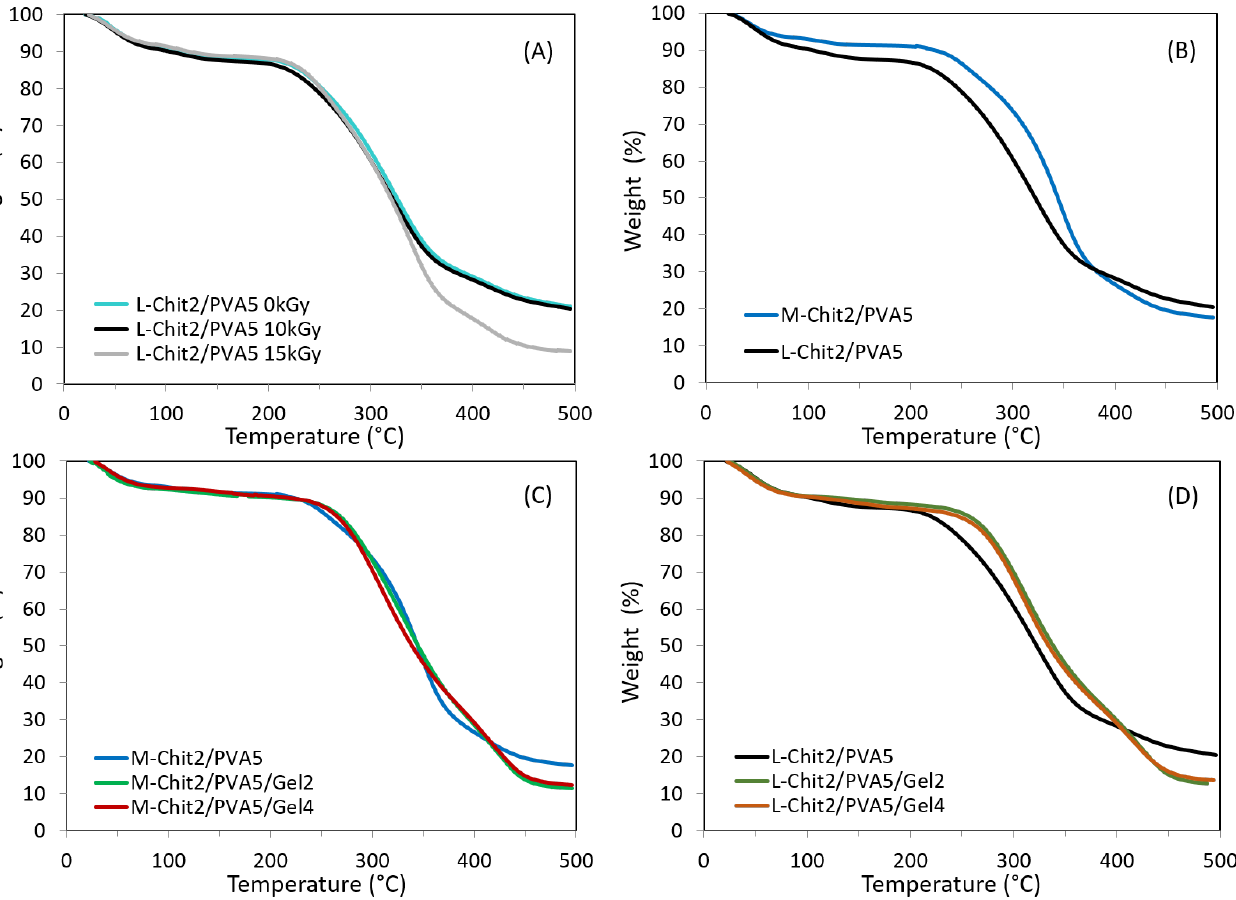
Figure 1. Membranes’ thermogravimetric curves of: ( A ) L-Chit/PVA irradiated at different radiation doses; and irradiated at 10 kGy: ( B ) medium and low Mw chitosan/PVA, ( C ) M-Chit/PVA with different content in gelatin, ( D ) L-Chitosan/PVA membranes with different content in gelatin.